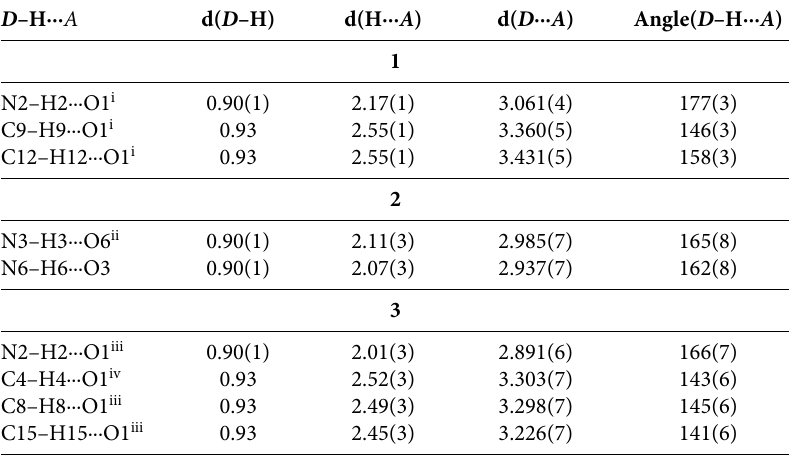
Table 2. Distances (Å) and angles (°) involving hydrogen bonding of the compounds D –H∙∙∙ A